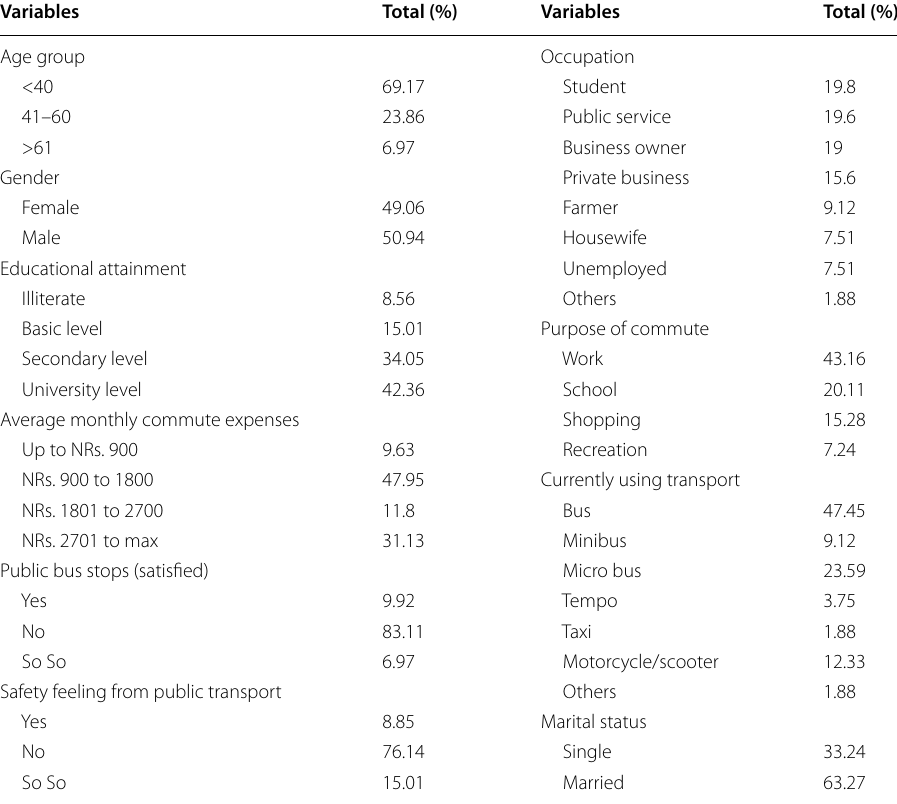
Table 2 Demographic and public transport service characteristics of respondents Variables Total